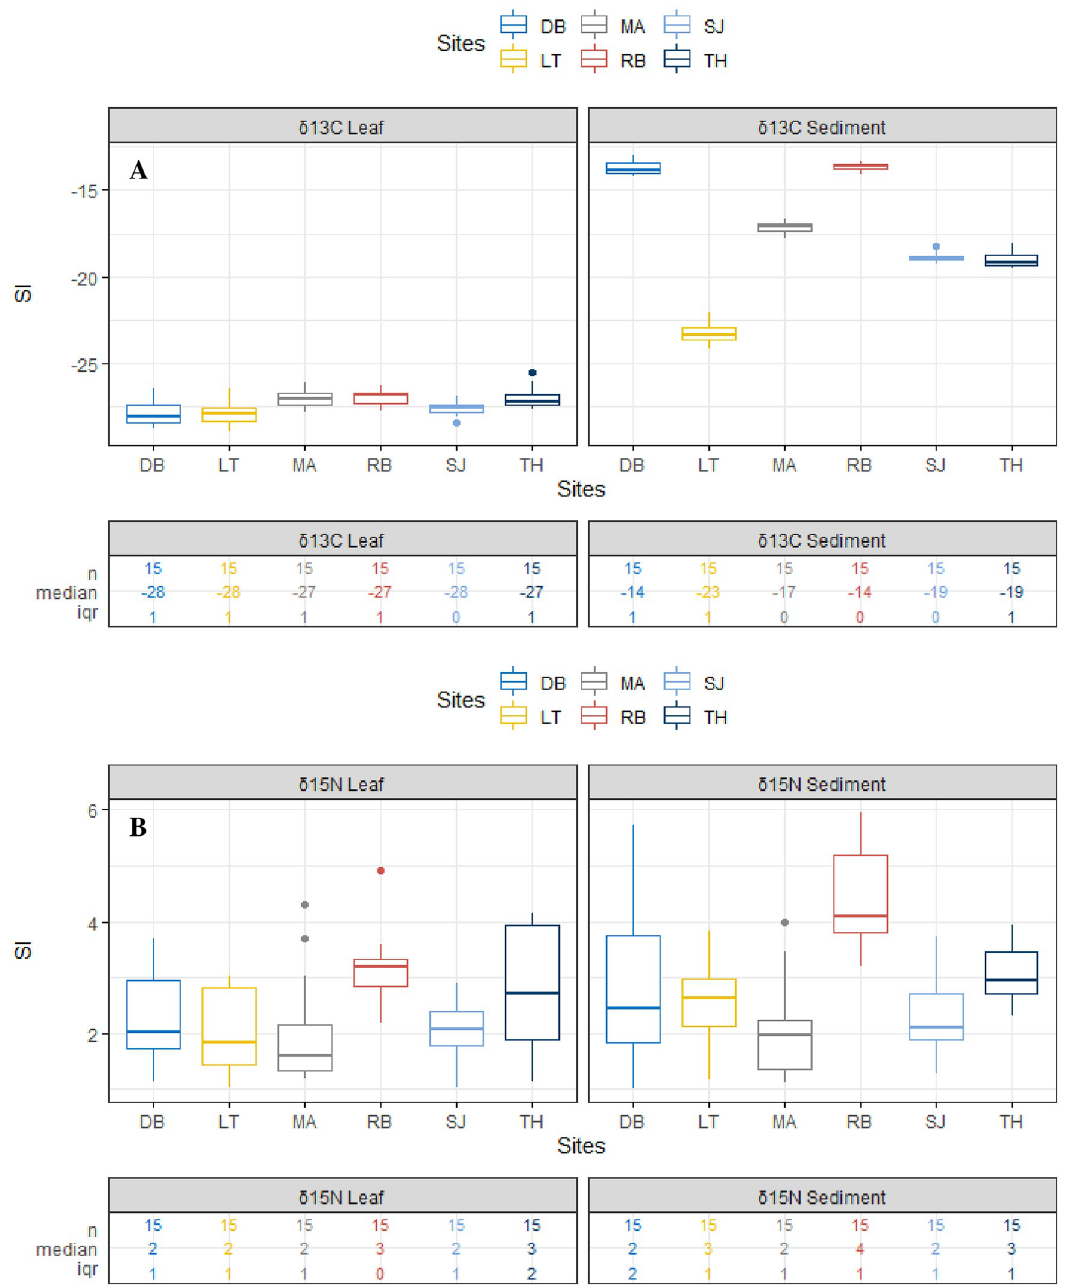
Fig 5. Boxplots showing (A) δ 13 C and (B) δ 15 N variability in sediment and A . marina leaves for the study sites on the coast of the central Red Sea and their corresponding median values. SI–Stable isotope value, iqr–interquartile range, LT-Al Lith,